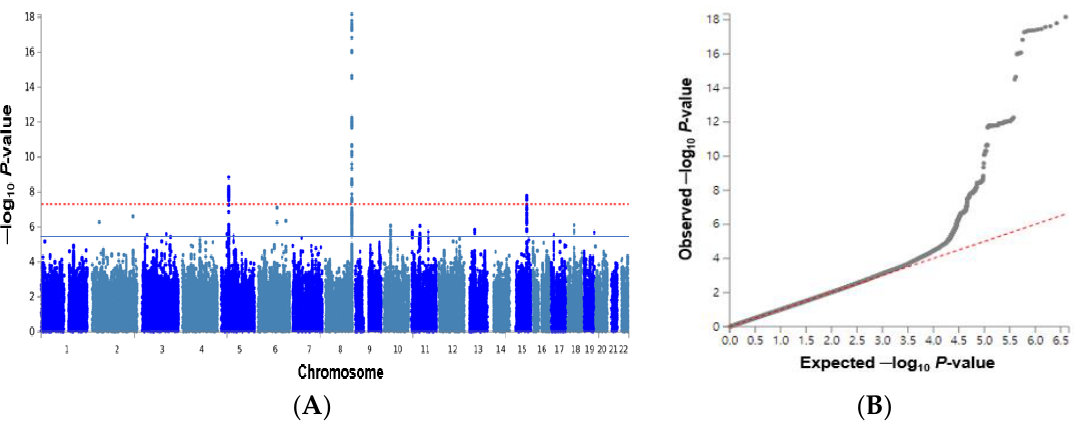
were positively associated with DU risk. The rs11230563_ CD6 (R225W) variant was located